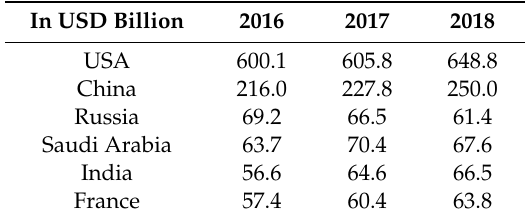
Table 1. Countries with the highest military spending worldwide in 2016–2018 (In Billion